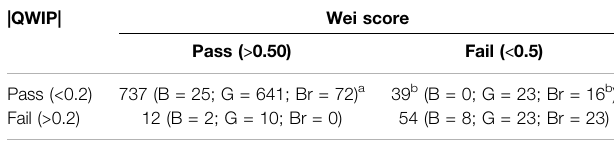
TABLE 1 | Comparison of approaches for WISP Lifewatch data. |QWIP| Wei score Pass ( >